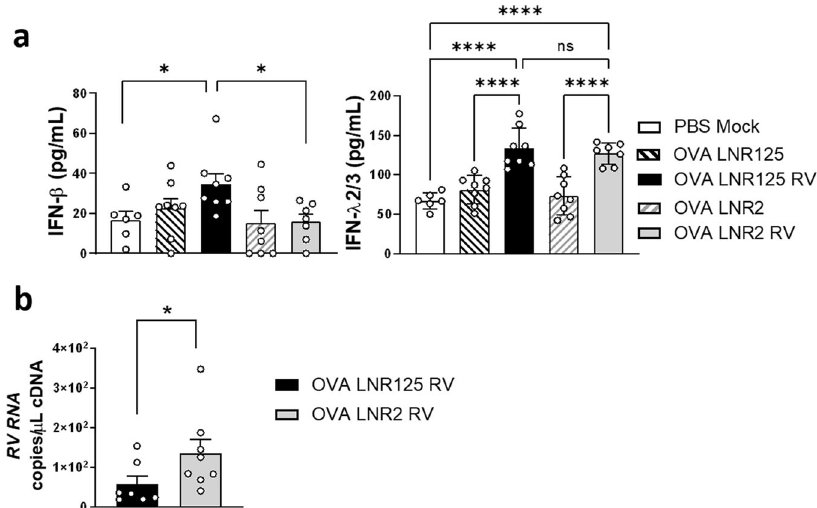
Fig. 6 IL-25 blockade enhanced IFN-secretion and reduced viral load in allergic mice and mice with RV-induced exacerbations. Mice were sensitised and challenged to ovalbumin (OVA). On the same day as the second challenge dose, mice were treated with LNR125 or LNR2, intraperitoneally followed by infection with RV-A1, 6 h post fi nal challenge. ( a ) Lung tissue was collected 1 day postinfection for IFN analysis by ELISA. ( b ) Viral load was quanti fi ed by Taqman qPCR analysis of apical lung lysates. Bars represent mean + SEM, n = 6 – 8 mice. * P < 0.05, ** P < 0.01, *** P < 0.001, **** P < 0.0001, ns = not signi fi cant by ( a ) or 1-way ANOVA with Holm-Sidak ’ s correction for multiple analyses ( b ) or Mann Whitney test for non-parametric